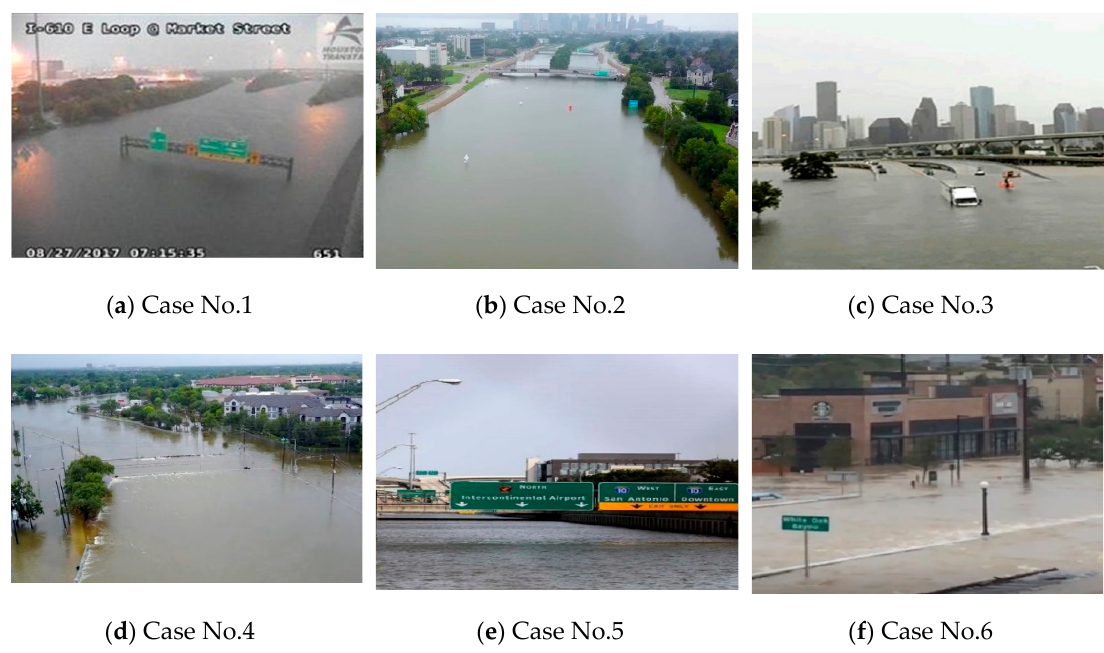
Figure 5. Example images used for inundation detection experiments which are No. 1 to No. 6 in Table 1 collected from CCTV and social media used in this paper. ( a ) and ( b ) are flooded roads during Hurricane Harvey collected from CCTV; others are collected from social media.